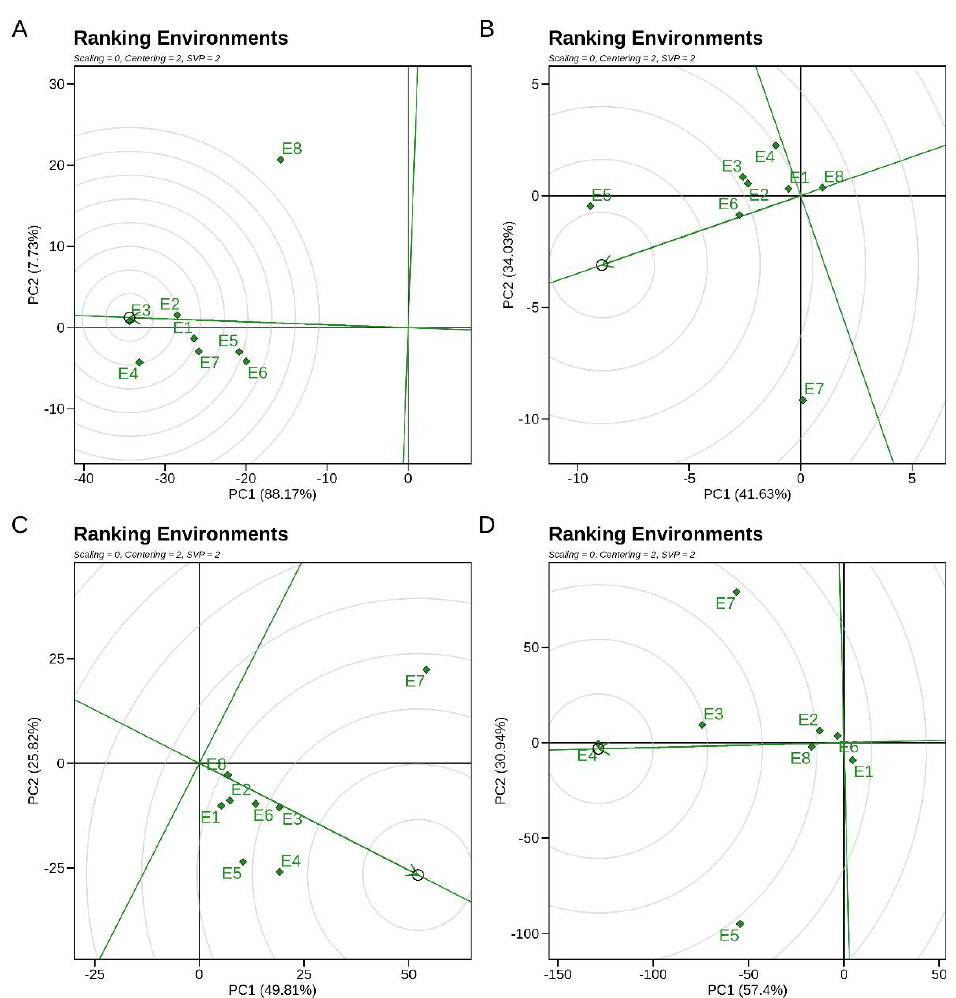
Figure 3. The GGE biplot ‘Ranking environments’ pattern to rank environments for the ideal env−ironment of 5 GSR lines and 2 control lines grown under eight environments in the year 2020 for ( A ) plant height, ( B ) the number of tillers, ( C ) grain yield, and ( D ) straw yield. The biplots were created with centering = 0, SVP = 2, and scaling = 0 parameters.